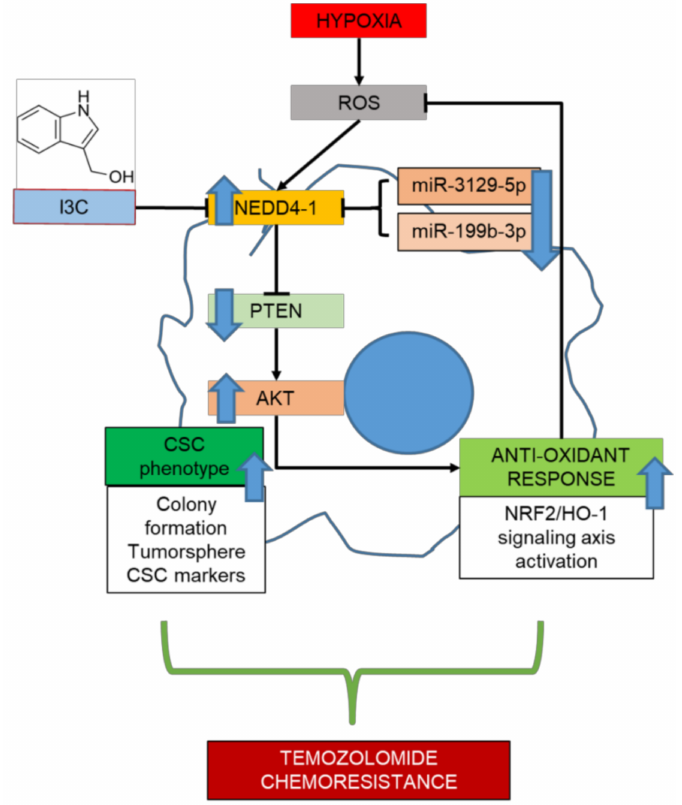
Figure 7. Graphical abstract. TMZ-resistant cells exhibited a dysregulated expression level of miR- 3129-5p and miR-199b-3p, which results in the aberrant expression of NEDD4-1. Up-regulated NADD4-1 modulate the expression of tumor-suppressor PTEN and promotes the AKT/NRF2/HO-1 oxidative stress signaling axis on TMZ-resistant GBM cells. Thus, a combination of I3C, a well-known inhibitor of NEDD4-1 with TMZ results in the synergistic effect in improving therapeutics outcomes on TMZ-resistant GBM